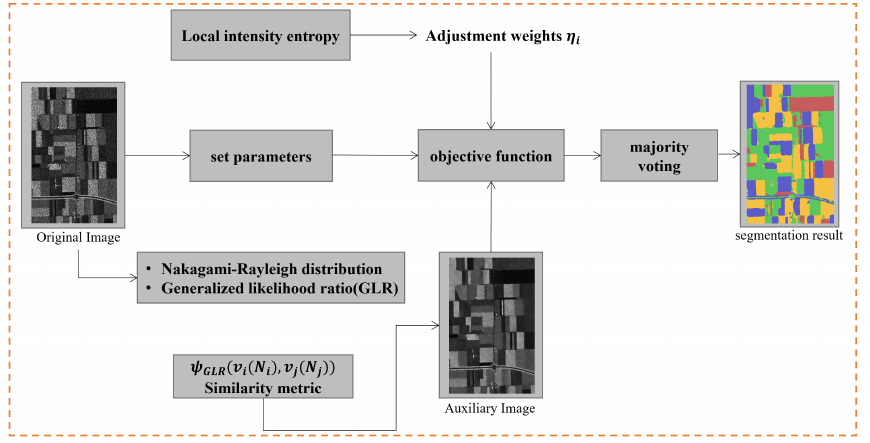
Figure 5. The framework of proposed segmentation algorithm GLR_FCM, and the LBNL_FCM is